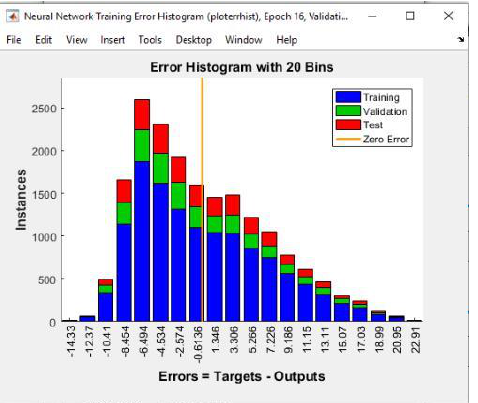
Figure 18 . shows the error histogram of the trained neural network for the training, validation and testing steps. This figure shows that the data fitting errors are distributed within a reasonably good range around zero.